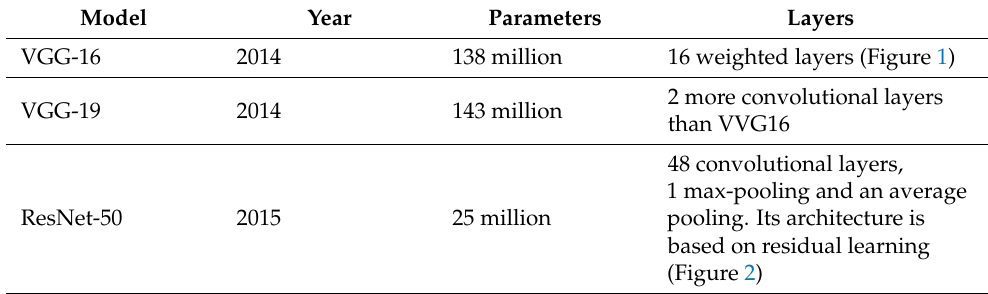
Table 1. Main characteristics of ImageNet pre-trained